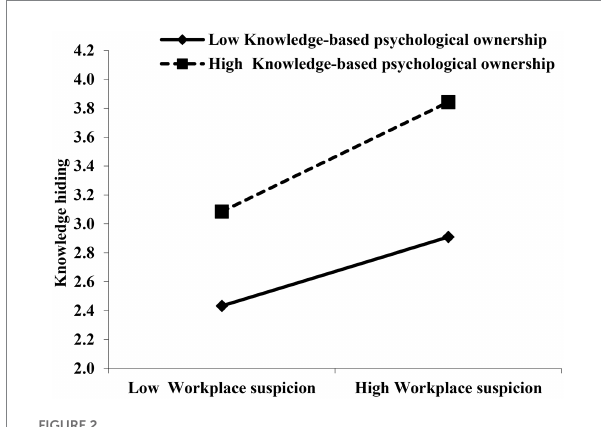
FIGURE 2 The moderating effect of knowledge-based psychological ownership on the relationship between workplace suspicion and knowledge